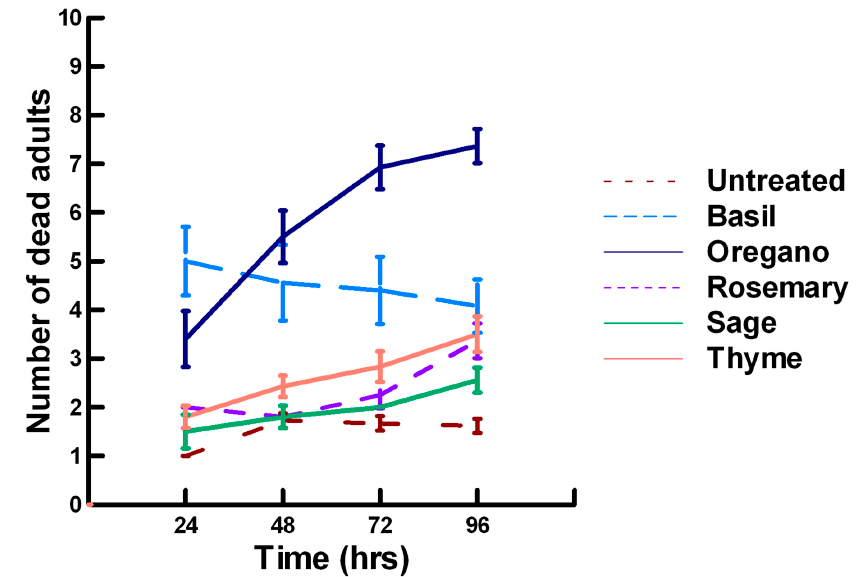
Figure 4. Acute contact toxicity with a high concentration of plant powders from the family Lamiaceae (basil, oregano, rosemary, sage and thyme) adherent to adult Pteromalus venustus . Means and standard error shown. Insects 2020 , 11 , x